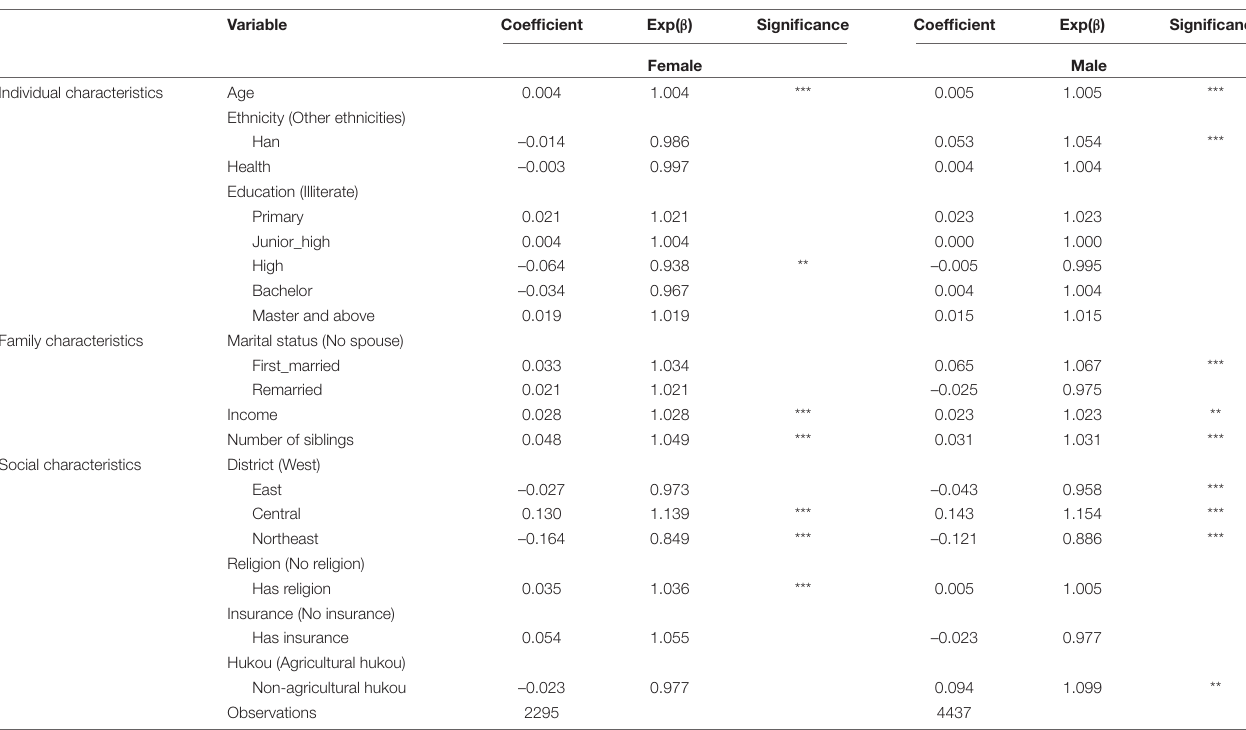
TABLE 9 | Logistic regression results by